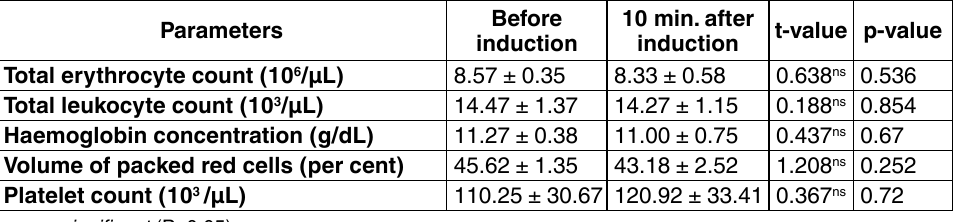
Table 1. Comparison of haematological parameters before anaesthetic induction and 10 minutes following anaesthetic induction (Mean ± SE) n = 12 Before Parameters